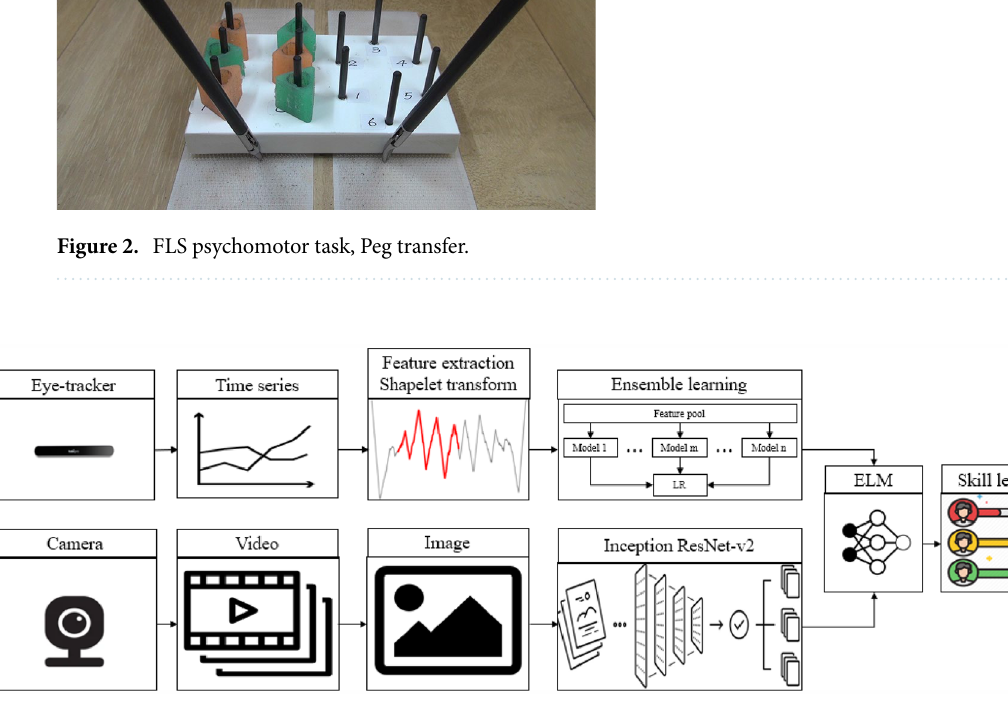
Figure 3. The design process of the eye tracking skill level detection